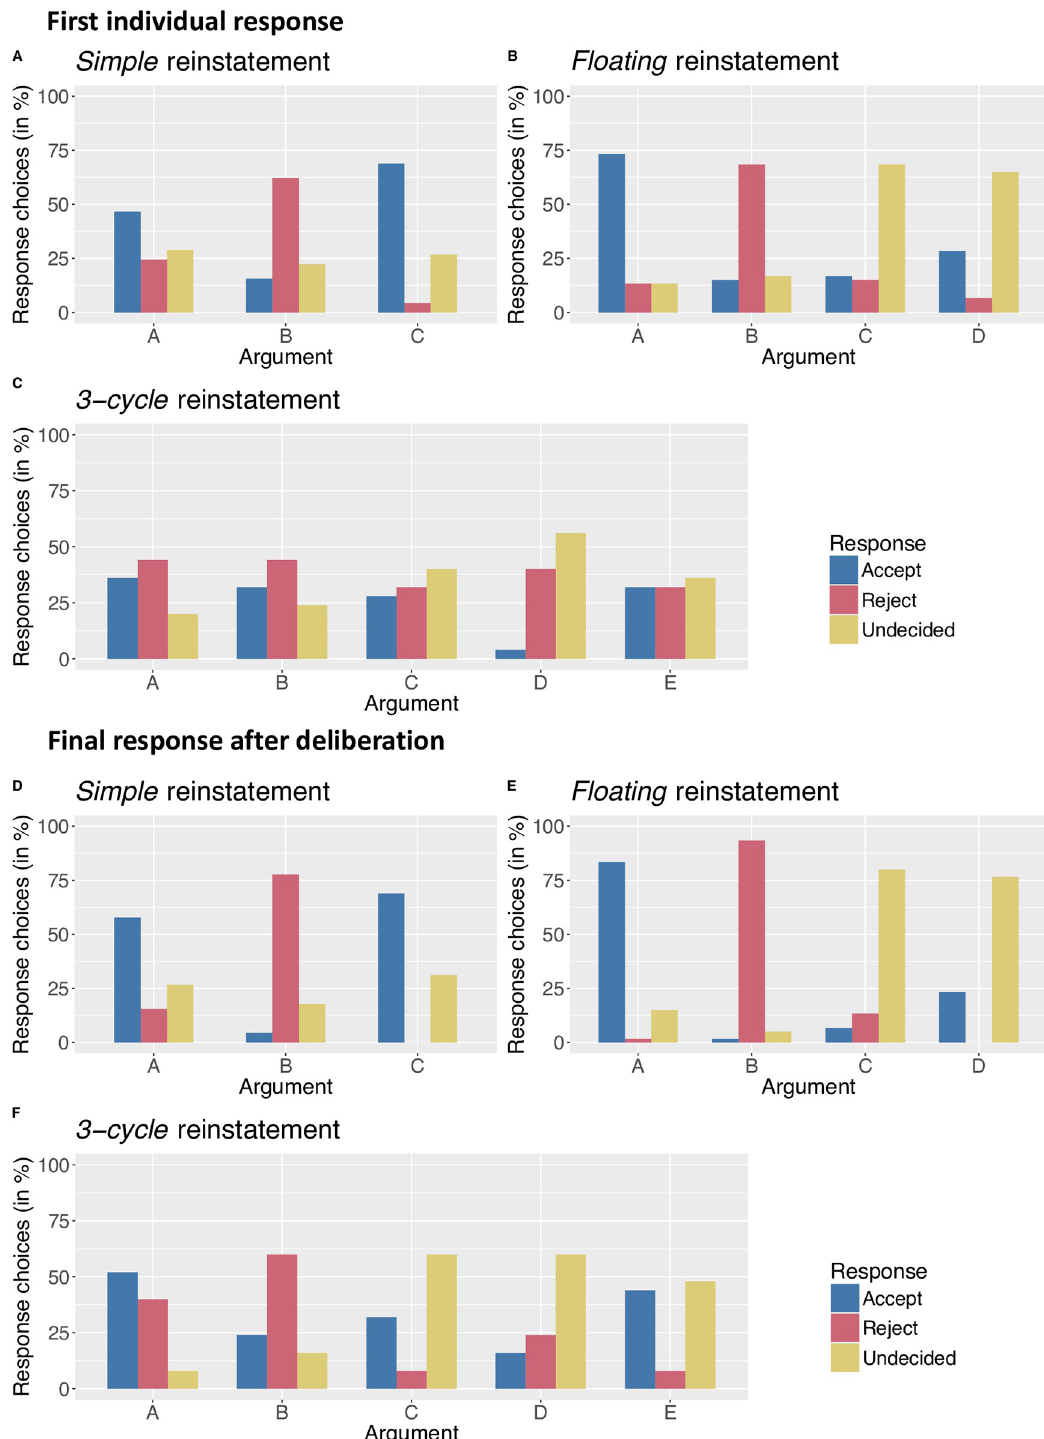
Fig 3. Percentage of responses in which participants chose to accept a corresponding natural language argument, to reject it, or to consider it undecided , for the three AF s. Data are provided for the first personal evaluation (upper part) and the last response after the group deliberation phase (bottom